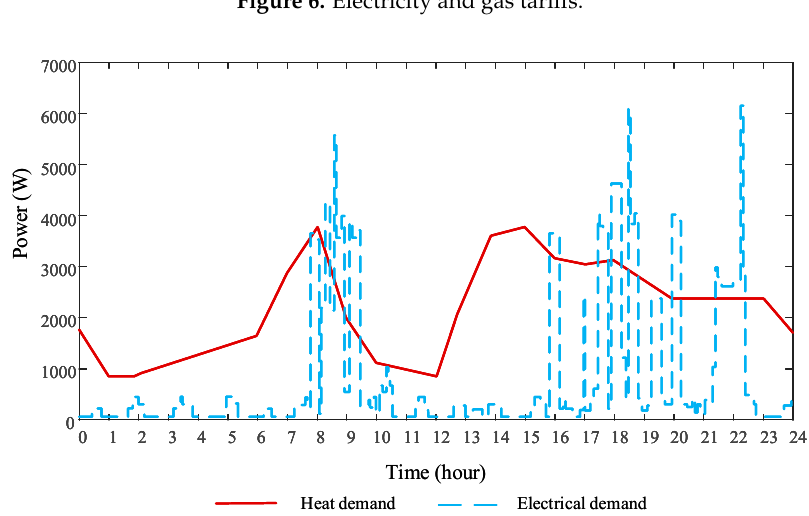
Figure 6. Electricity and gas tariffs.